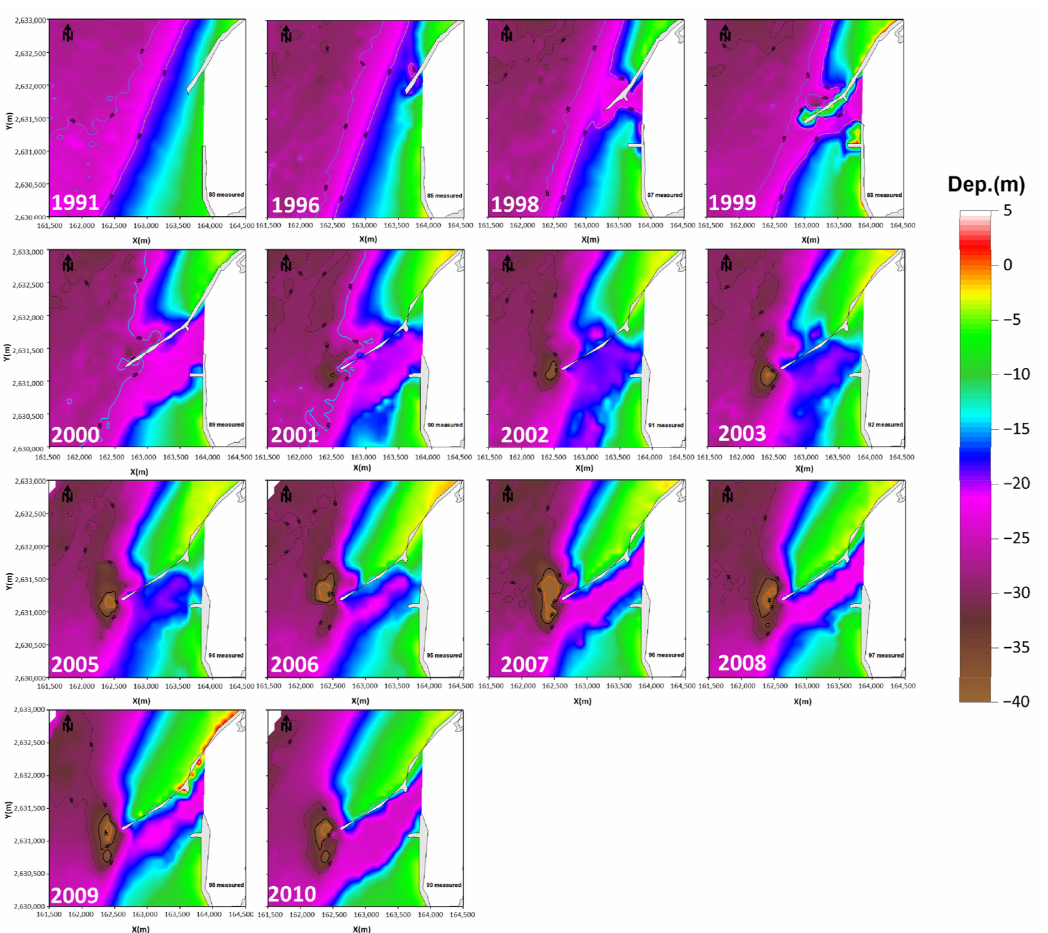
Figure 7. The topographic data near Mailiao West